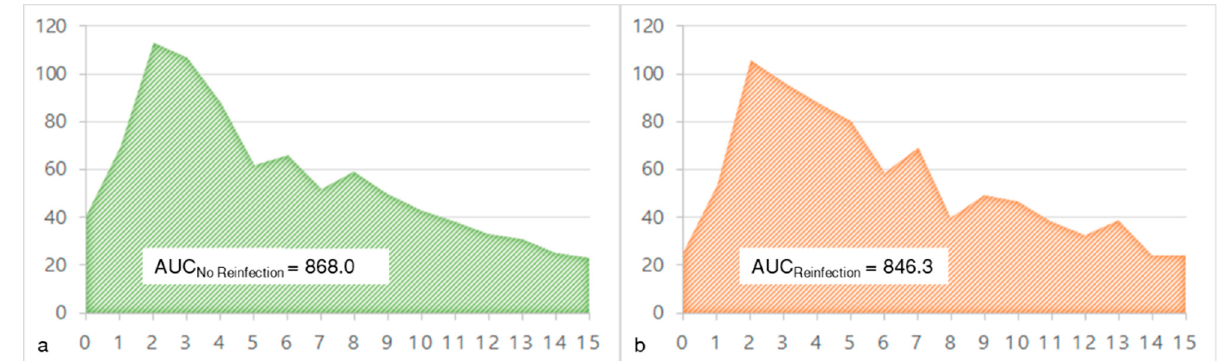
Figure 5. Mean C-reactive protein (CRP) value preoperatively and in the further clinical course of patients without reinfection (blue curve) and with reinfection (green curve).